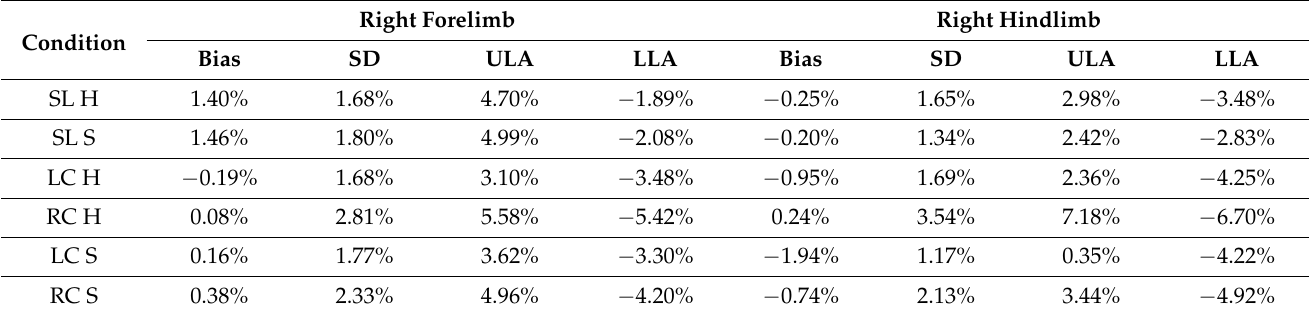
Table 3. Bland–Altman comparison (in percentage of stride duration%) of the reference foot-off event and the foot-off event detected with the developed method from the cannon bone data. Accuracy (bias), precision (SD), and upper/lower limits of agreement (ULA and LLA) were indicated for each condition: straight line (SL), left circle (LC), and right circle (RC), for both ground conditions—hard (H) and soft (S)—and for the right forelimb and right hindlimb. For the left-circle condition, the equipped limb was the one outside the circle. For the right-circle condition, the equipped limb was the one inside the circle. Results are in percentage of stride duration.